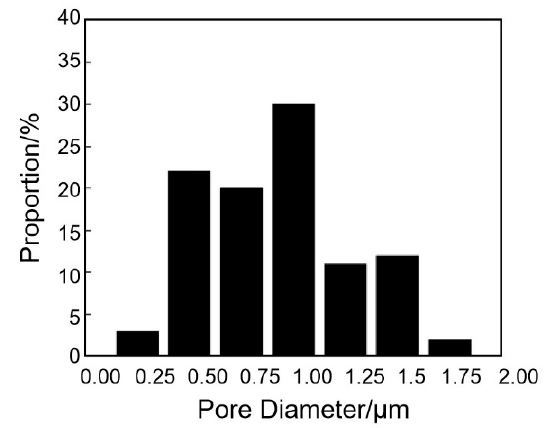
Figure 4. Pore diameter distribution for the YSZ coating samples. Table 2. Porosities and pore diameters of the YSZ coating for evaluation by simulated work. Pore